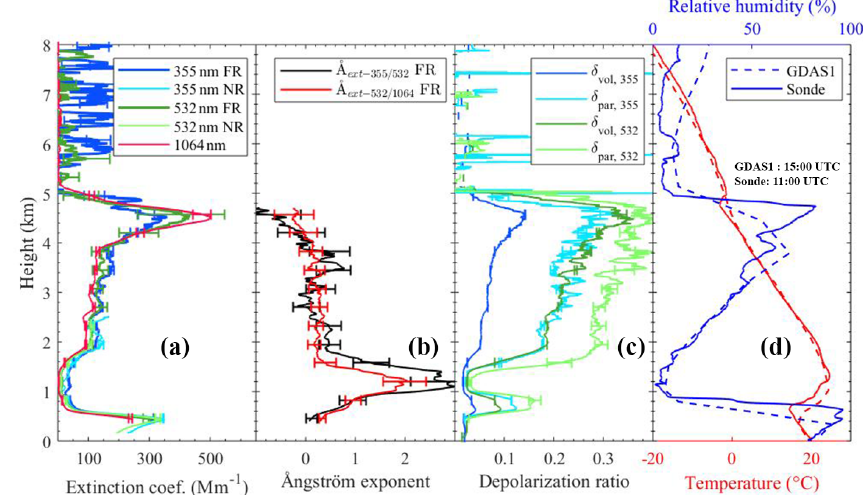
Figure 14. Height profiles of (a) particle extinction coefficients at 355nm (blue, FR from far-range signal, NR from near-range signal), 532 (green) and 1064nm (red), (b) Ångström exponents computed from different wavelength pairs in panel (a) , (c) volume ( δ vol ) and particle ( δ par ) depolarization ratios and (d) relative humidity (blue) and temperature (red). The lidar observations were taken on 30 May 2018 at 16:00–16:59UTC. The radiosonde was launched at 11:00UTC. GDAS1 data are for 15:00UTC.